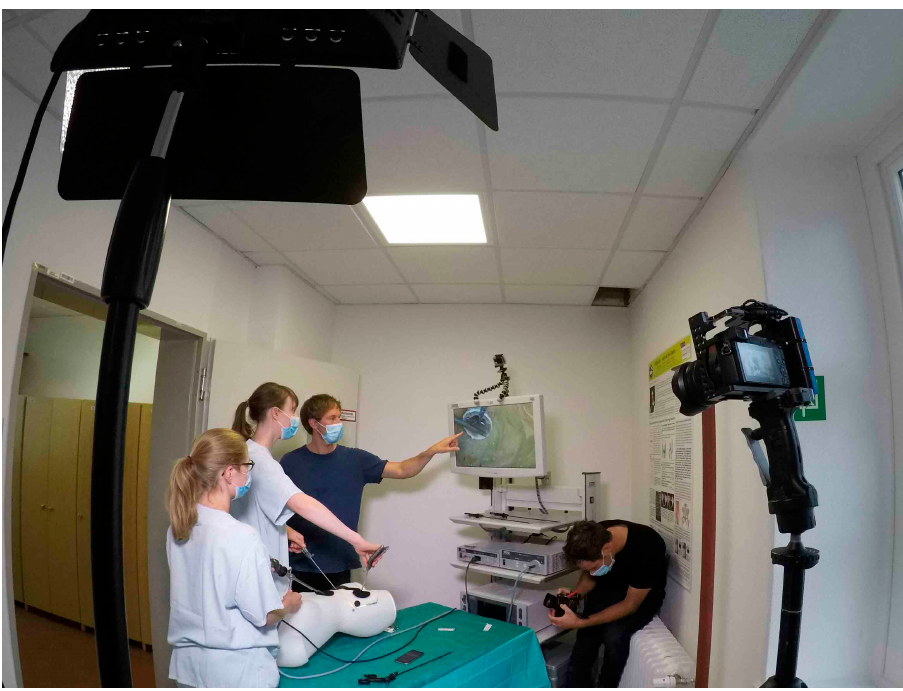
Figure 1. Setup of video feedback.